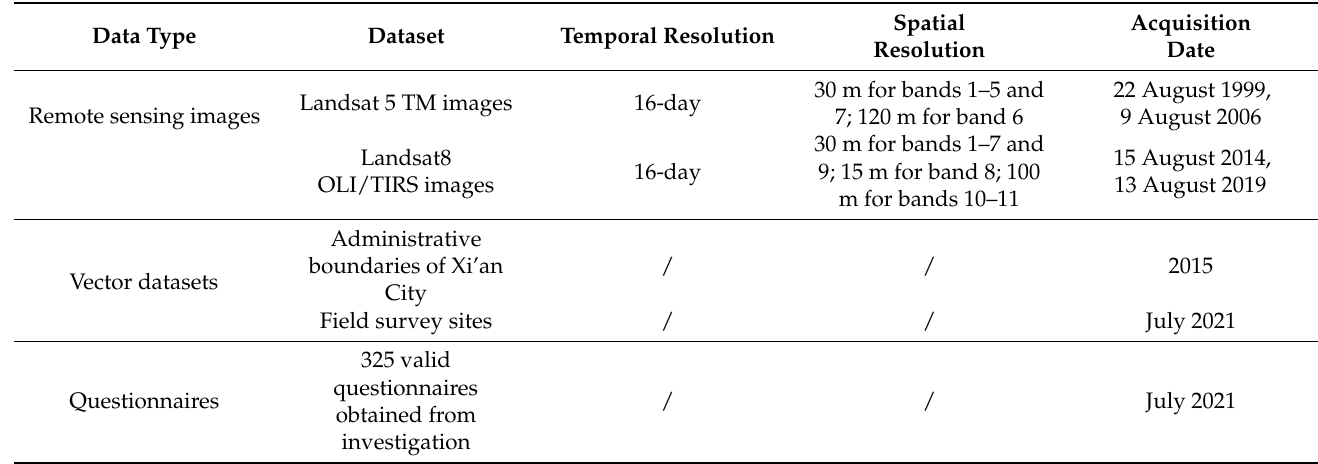
Table 1. Information of